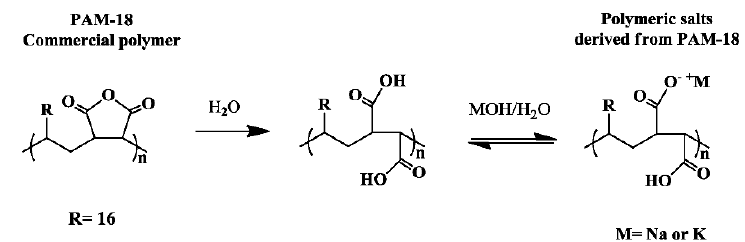
Figure 1. Scheme of the ionization process of polymers derived from poly(maleic anhydride- alt -octadecene) (PAM-18).